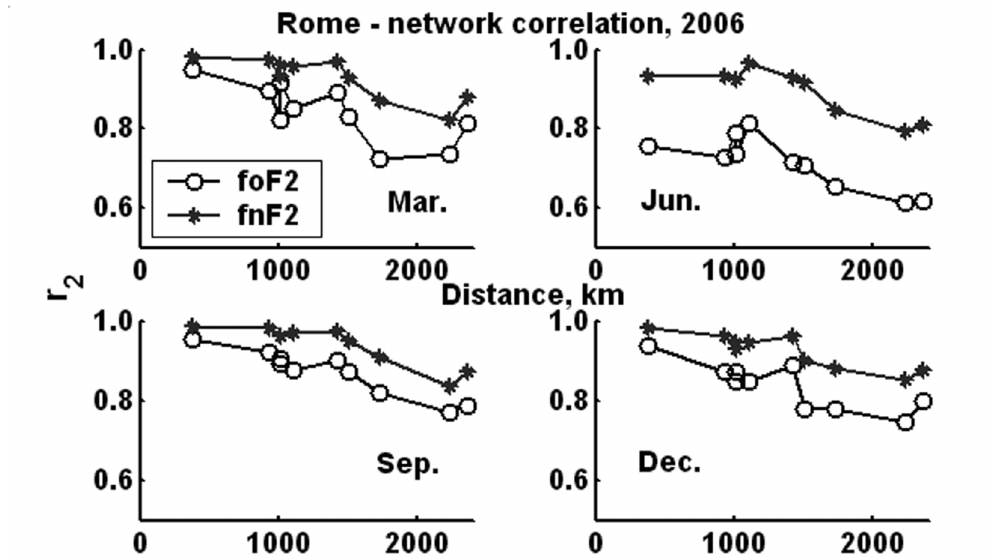
Fig. 3. Correlation coefficient for observed foF2 and c -transformed fnF2 in terms of the distance between the